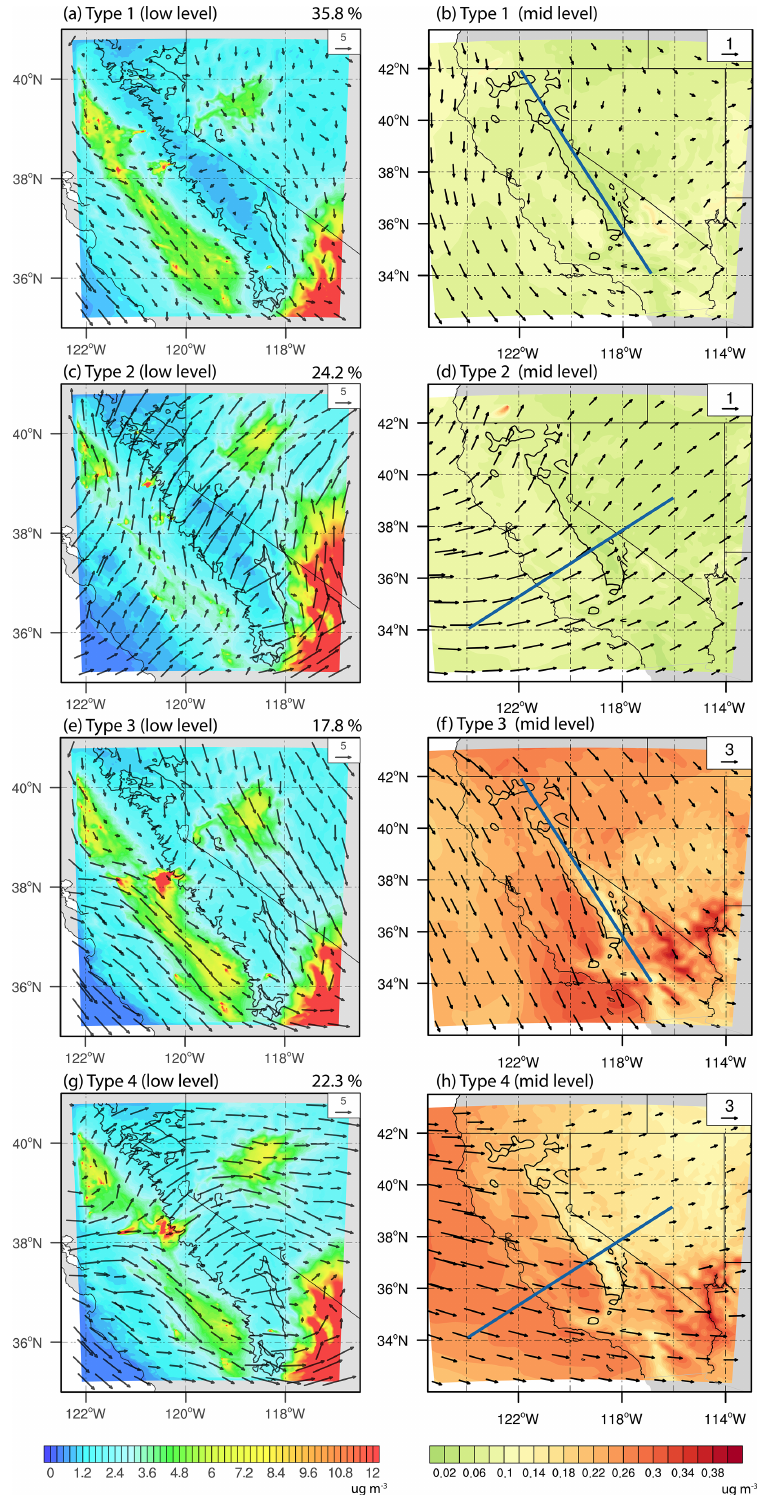
Figure 3. (a, c, e, g) Low-level (roughly 875–925hPa) dust concentration (ugm − 3 ) and wind vectors (ms − 1 ) in each of the four SOM types in WRF-Chem. The numbers on the top right of panels denote the frequency of each type. (b, d, f, h) Mid-level (200–700hPa average) dust concentration (ugm − 3 ) and dust transport in types 1–4. The position of the cross-section used for Fig. 5 is denoted in each plot.